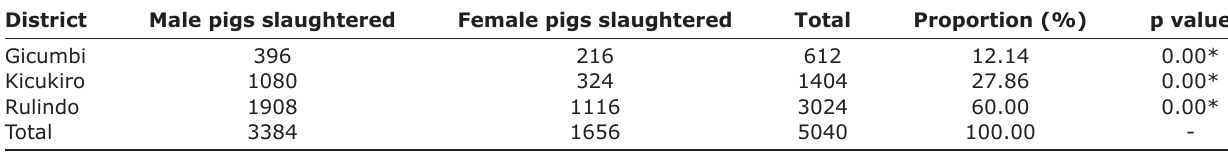
Table-1: Total number of pigs that were slaughtered at Base Abattoir categorized according to district of origin and sex. District Male pigs slaughtered Gicumbi